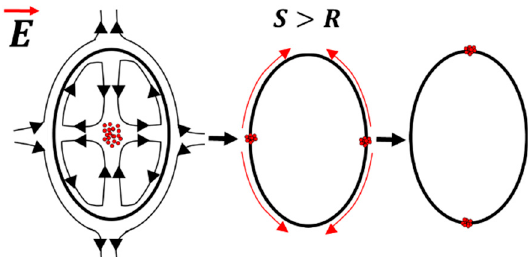
Figure 5. Schematic showing the transfer of particles from the suspension to the emulsion interface by electric field. Here, permittivity ratio ( S ) between the droplet and the outside liquid is greater than the conductivity ratio ( R ).